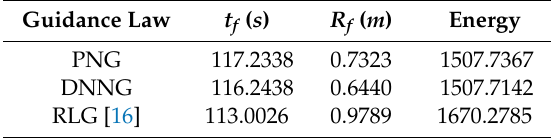
Table 2. Performance comparison of three guidance laws for 100 random initial conditions.